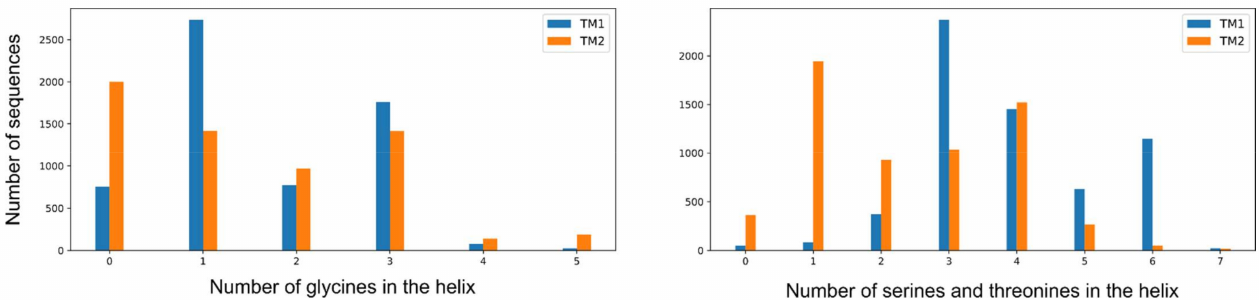
Figure 10. Abundance of glycines, serines, and threonines in transmembrane α -helices in NSHKs. Each TM helix (TM1 and TM2) on average contains one to two glycines and three to four serines or threonines.